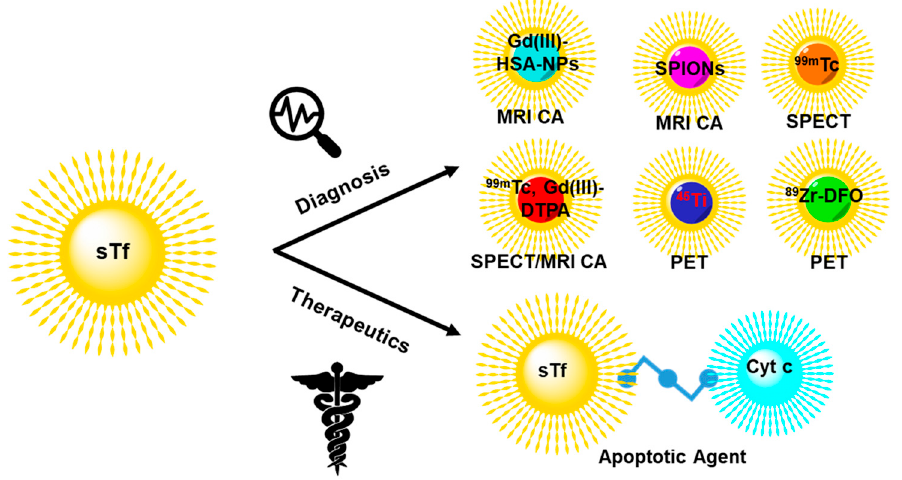
Figure 18. Engineering of sTf for delivery of select metal-based diagnostic and therapeutic biomedical tools for cancer applications.